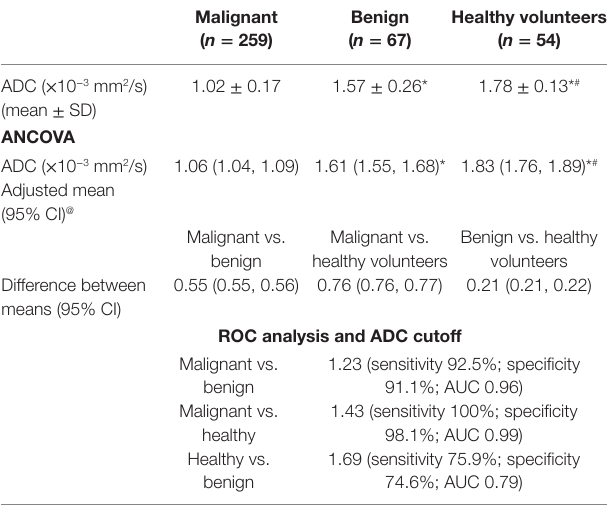
TaBle 2 | Distribution of mean aDc in malignant and benign breast lesions, and healthy breast tissue of volunteers and cutoff aDc values using rOc analysis.